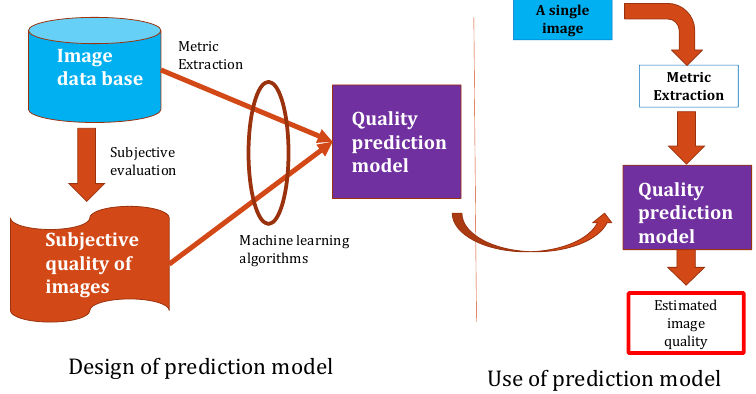
Figure 1. Objective image quality assessment